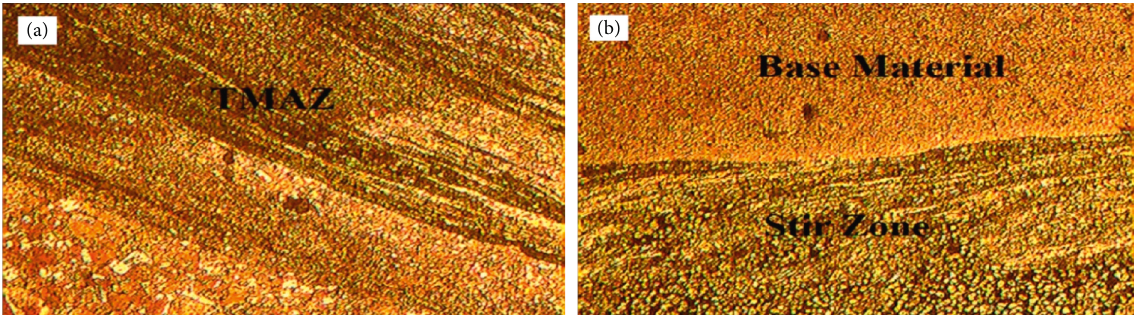
Figure 5: OM image at the rotational speed of 1400rpm (a) TMAZ (b) Stir zone.